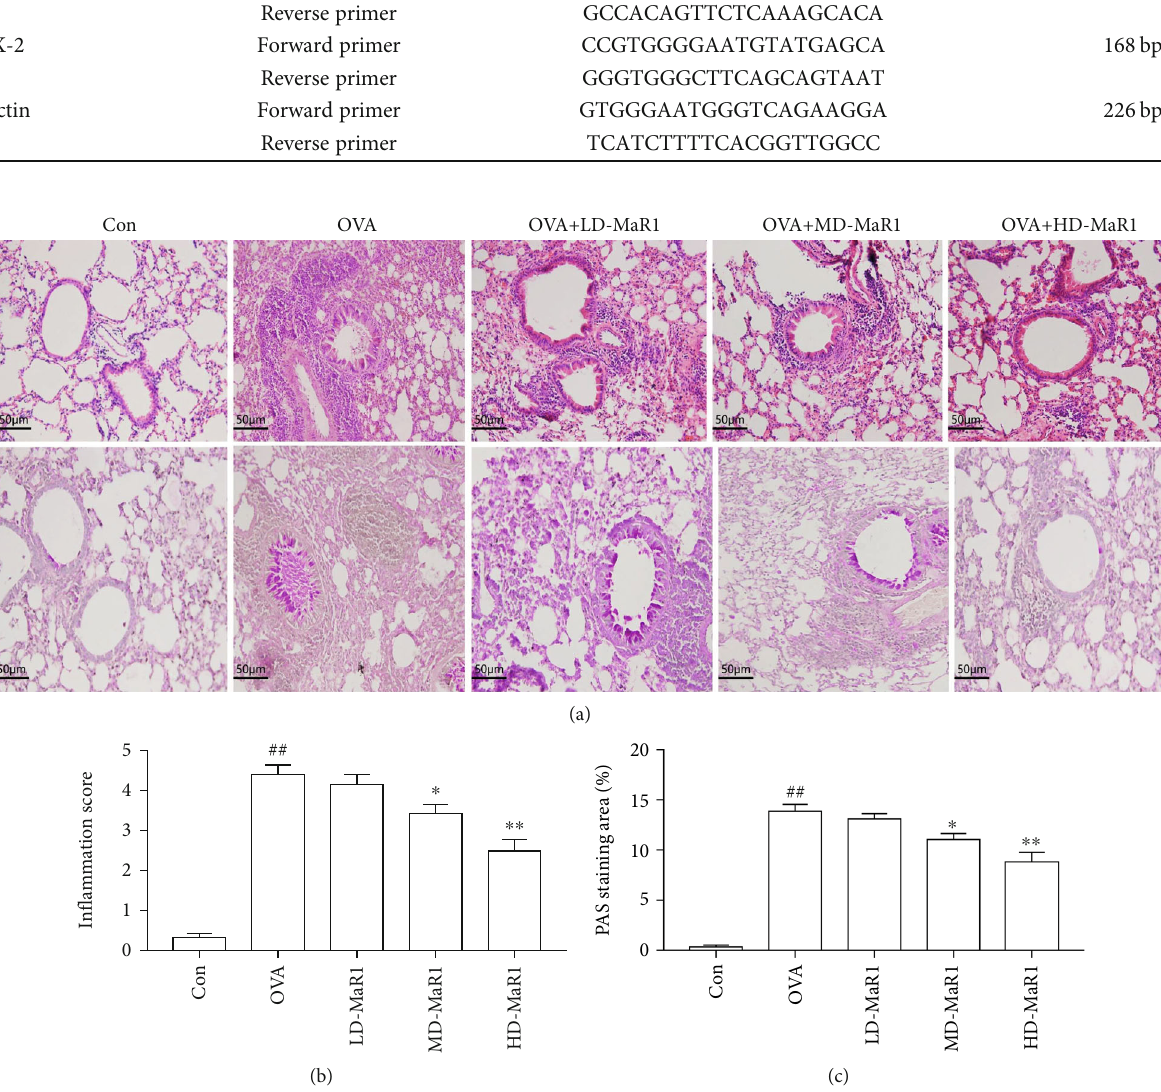
Figure 2: MaR1 treatment suppressed OVA-induced allergic airway in fl ammation. (a) H&E and PAS staining were used to evaluate in fl ammatory cell in fi ltration and mucus production in the lung ( × 200). (b) In fl ammation score. (c) The PAS staining area (%). Data expressed as mean ± SEM ( n = 6/group ). ## P < 0 : 01 , # P < 0 : 05 vs. the control group; ∗ P < 0 : 05 , ∗∗ P < 0 : 01 vs.